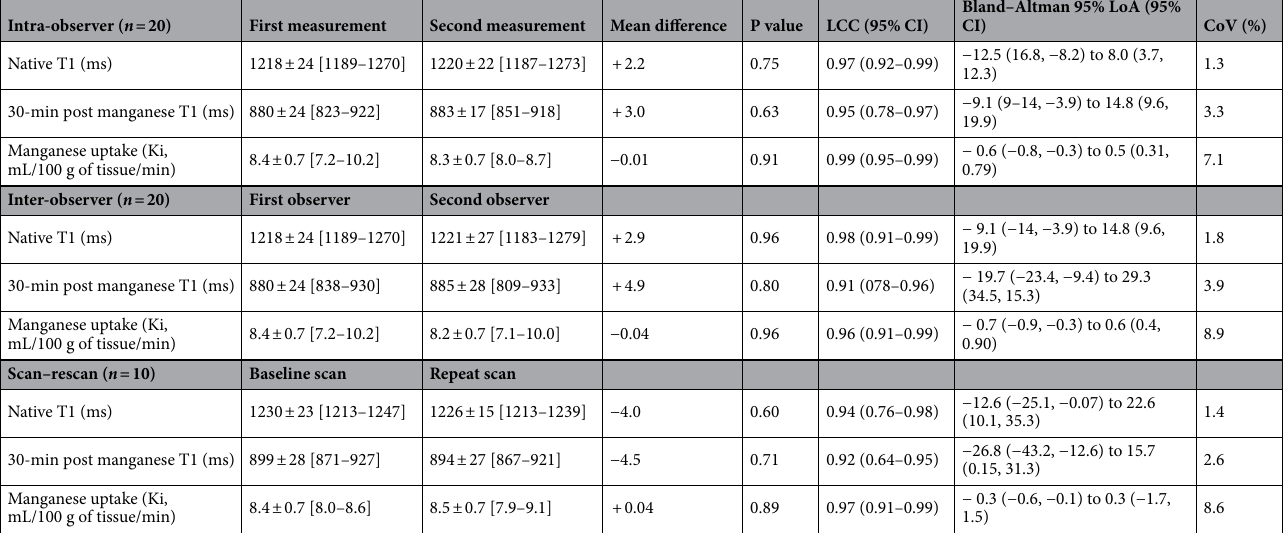
Table 1. Intra-observer, inter-observer repeatability and scan-rescan reproducibility for healthy. Mean ± standard deviation [95% confidence interval]. LCC Lin’s concordance correlation, LoA limits of agreement, CoV coefficient of